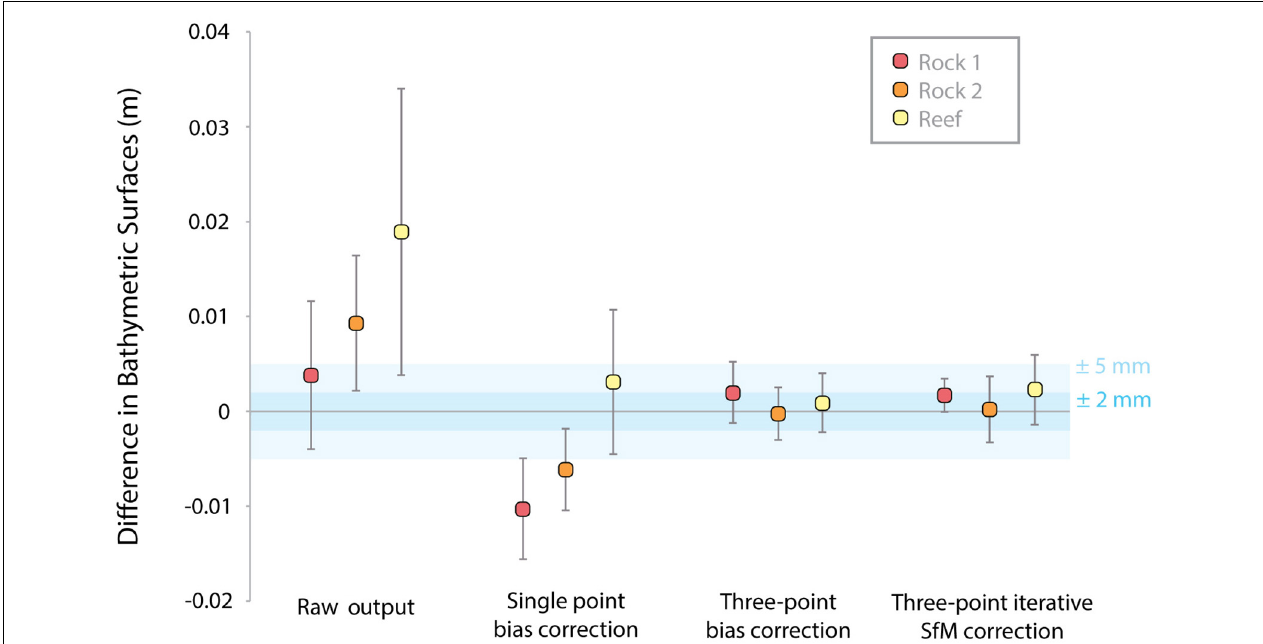
FIGURE 11 | Summaries of the differences in stationary objects at the Surface Elevation Table (SET) station 1 site during the two surveys. Three different objects were used for measurements, the locations of which are shown in Figure 10 , and four comparative techniques were used as detailed in the text. Differences computed from M3C2 measurements of the point clouds, and the mean and standard deviation of the measurements are shown with the point and error bars, respectively. Shading highlights differences that are ± 5 mm and ± 2